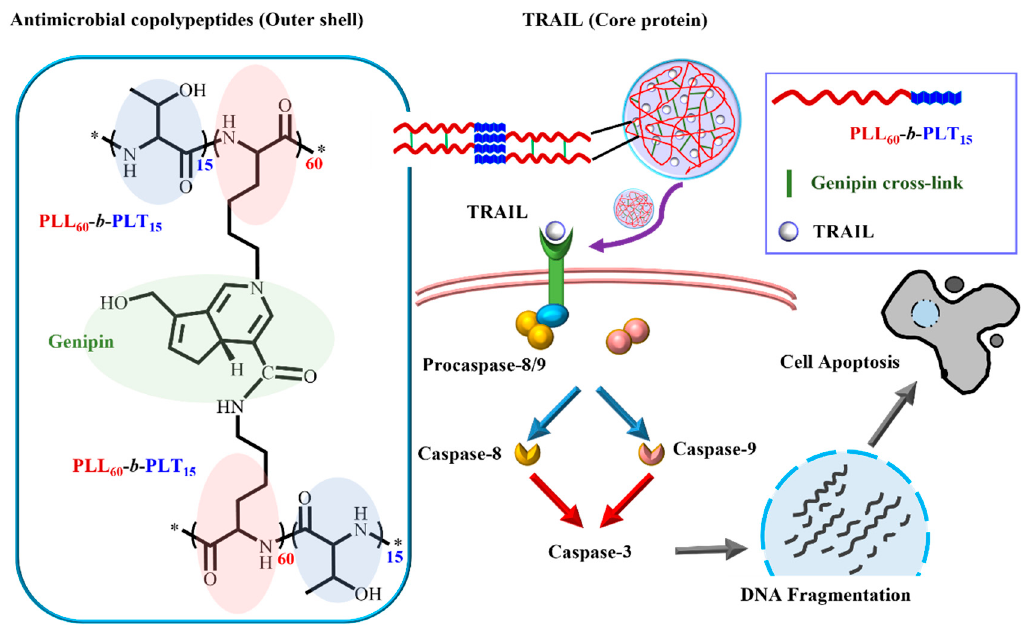
Figure 1. Schematic illustration of TRAIL encapsulated in bactericidal polypeptide nanogels, adapted from [36], published by Elsevier, 2019.